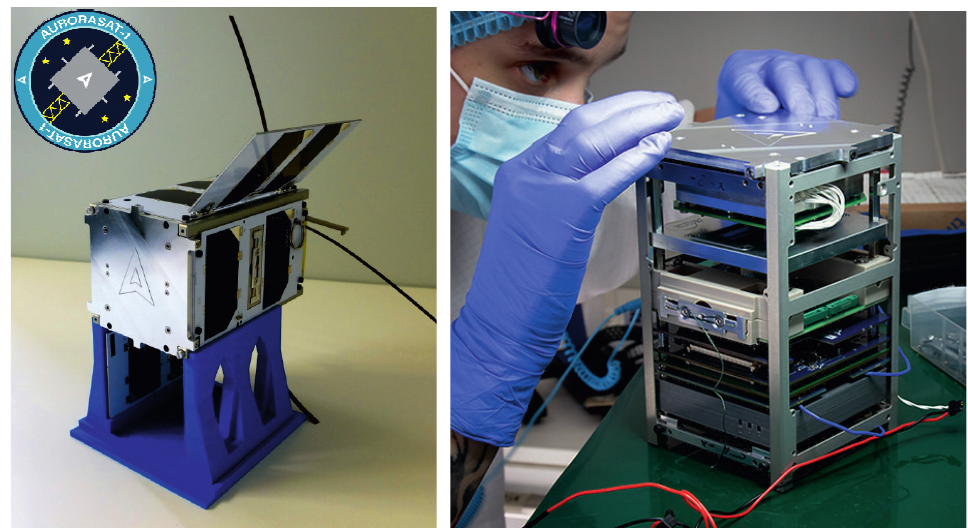
Figure 1. AuroraSat-1 includes a PB device for de-orbiting purposes at the end of its life. Image from Aurora Propulsion